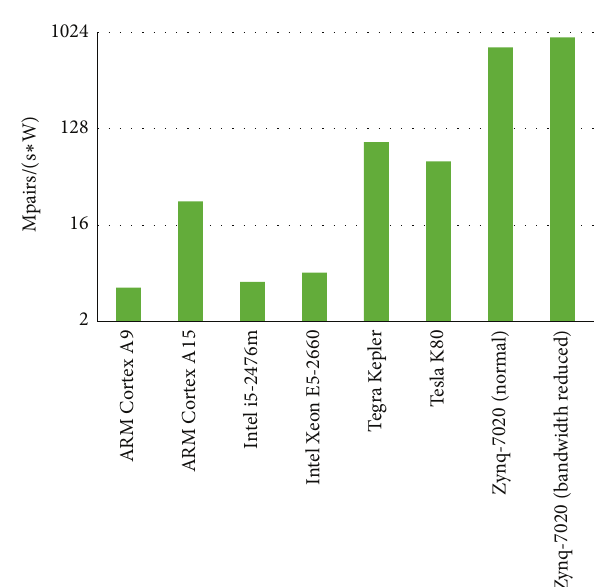
Figure 8: Comparison on performance per